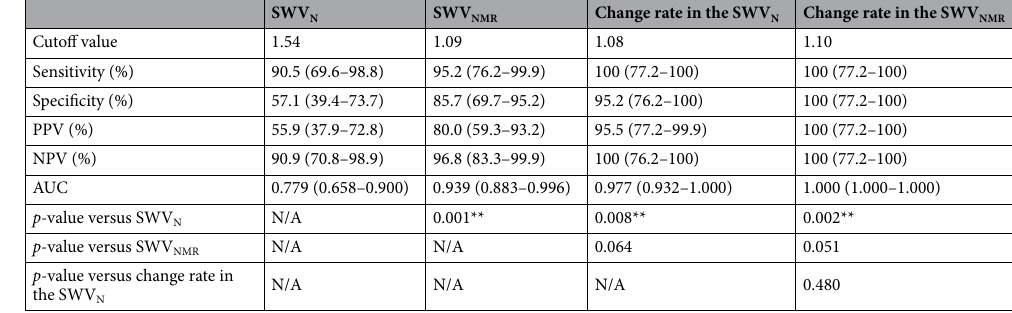
Table 3. Sensitivity, specificity, and positive and negative predictive values according to cutoff values. PPV positive predictive value, NPV negative predictive value, AUC area under the receiver operating characteristic curve. Numbers in parentheses are 95% confidence Intervals. SWV N shear wave velocity of the sciatic nerve, SWV NMR the ratio of shear wave velocity of the nerve to muscle, N/A not applicable, ** p <